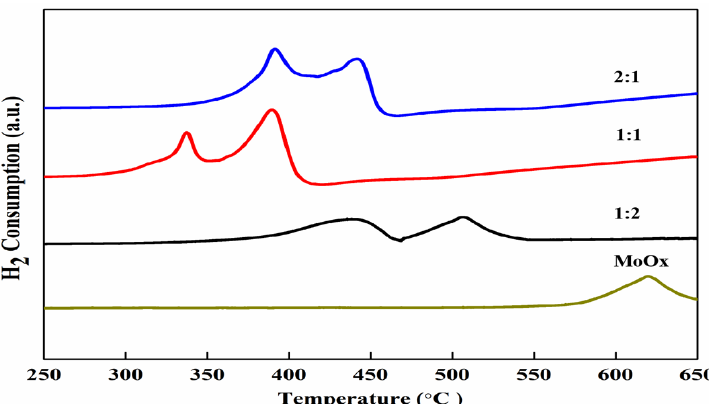
Figure 4. H 2 − TPR profiles of pre-reduced Cu/MoO x and MoO x at 450 °C under the flow of 4% H 2 /Ar mixture gas for 2 h.